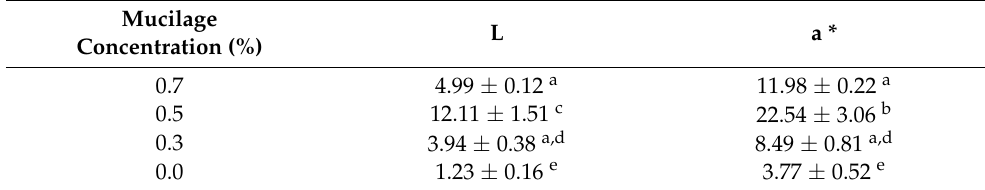
Figure 4. CSLM microphotographs of the capsules made from mucilage–alginate with rhodamine B. LRP (large, retained particles). Table 4. L *a * color values obtained from image processing, acquired by